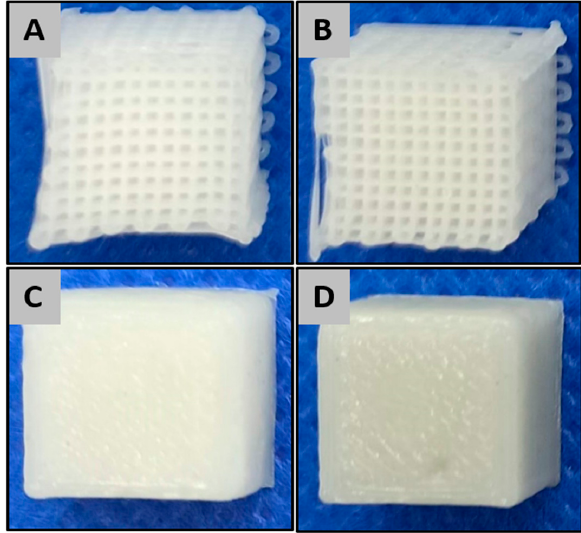
Figure 13. Scaffold design for mechanical testing. ( A ) porous structure of PCL scaffolds, ( B ) porous structure of PCL+BCP scaffold, ( C ) solid structure of PCL scaffolds, ( D ) solid structure of PCL + BCP scaffold.